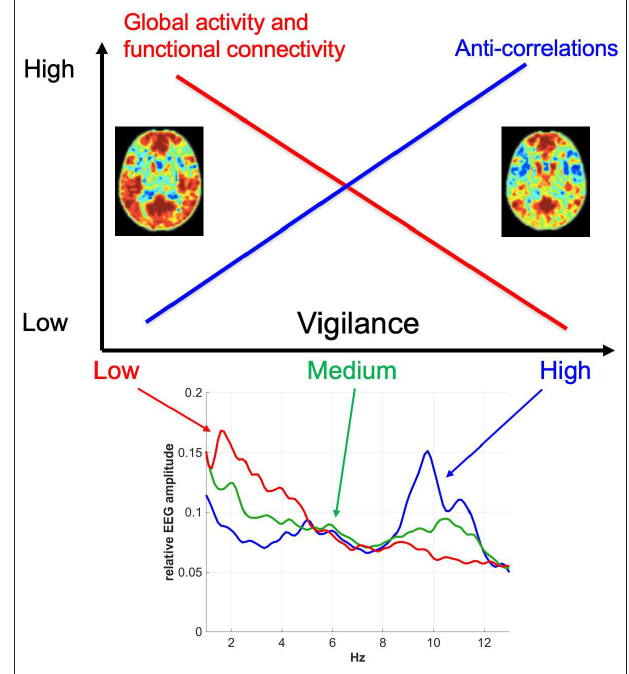
FIGURE 3 | Overview of the relationship between vigilance and rsfMRI signal amplitude and functional connectivity. In general, vigilance is negatively correlated with rsfMRI signal amplitude, with higher vigilance levels corresponding to global reductions in fMRI activity and functional connectivity. These reductions are associated with a greater presence of anti-correlations in functional connectivity maps at higher vigilance levels. The functional connectivity maps were obtained using a seed signal from the posterior cingulate cortex and acquired before (left) and after (right) the administration of caffeine ( Wong et al., 2012). The bottom plot shows representative EEG spectra for low, medium, and high vigilance levels (Wong et al.,